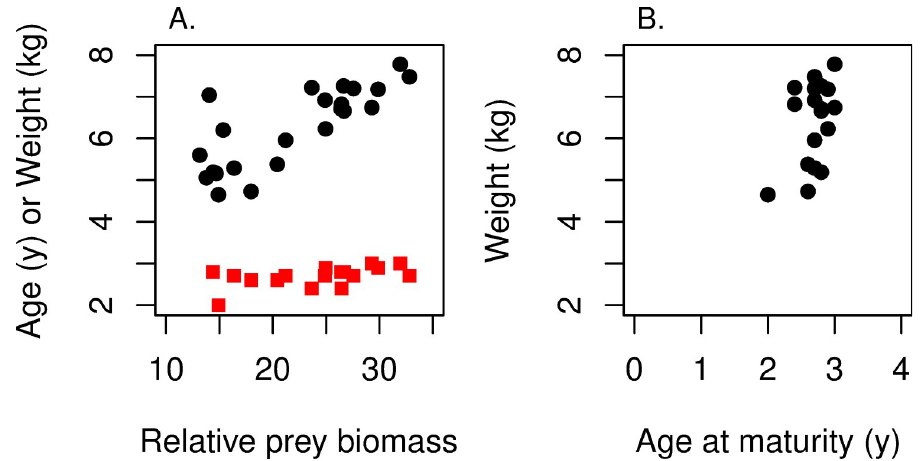
Fig 14. Weight and age at maturity for female Chinook Salmon in Lake Michigan. (A) Weight at maturity in kg (black circles) and age at maturity in years (red squares) for female Chinook Salmon in Lake Michigan each year for the period 1991–2008 [37] in relation to the relative prey biomass (tons of Alewife/tons of Chinook Salmon). (B) Weight at maturity relative to age of maturity for these same points. In both panels, we see small changes in age at maturity and relatively large swings in size at maturity.